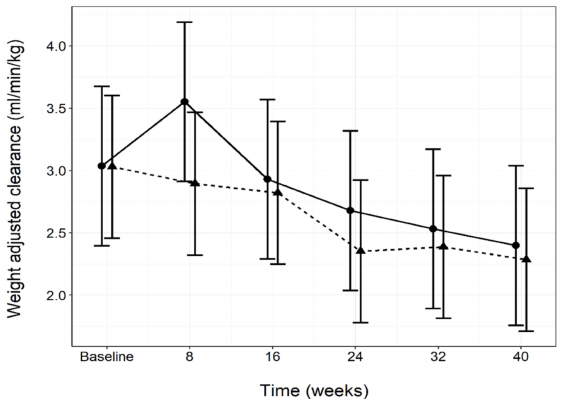
Figure 3. Glomerular filtration rate estimated by iohexol clearance, measured throughout the study in both the control ( n = 8; — • —) and test ( n = 10; — (cid:78) —) diet groups. Data values are presented as means per diet group per time point and 95% confidence